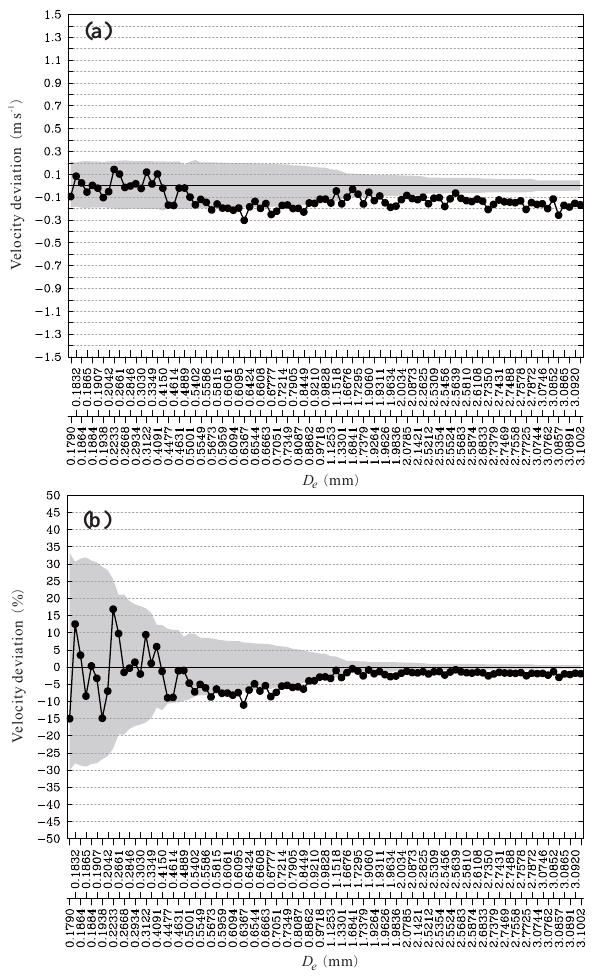
Figure 7. Velocity error analysis of the HSC-observed DFSs for all analyzed drops. Solid curve with black dot in (a) and (b) indi- cates, respectively, the V e values (i.e., the difference between the HSC-observed DFS and theoretical V t ) and their percentiles (i.e., normalized by their corresponding V t at D e ) . Shading highlights the range of velocity uncertainties (i.e., V s in Eq. 6) due to the po- tential size error (cid:49)D ± 0.040–0.045mm associated with the HSC measurements.